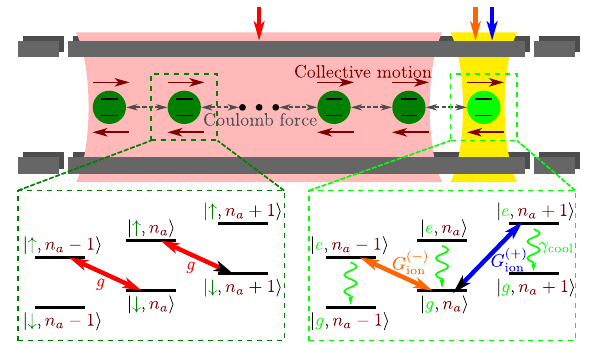
FIG. 9. Sketch of the trapped-ion setup discussed in Sec. VII A using N system ions (dark green circles) and one cooler ion (light green circle) oscillating in a collective motional mode ˆ a (thin brown arrows). The system ions are coupled to the motional mode at a coupling rate g by a red sideband drive of a metastable transition j ↑ i ↔ j ↓ i . The squeezed bath for the motional mode ˆ a is engineered by driving the cooler ion simultaneously on the red and blue motional sidebands (at rates G ð of a short-lived transition j e i ↔ j g i with a decay rate γ (squiggly light green